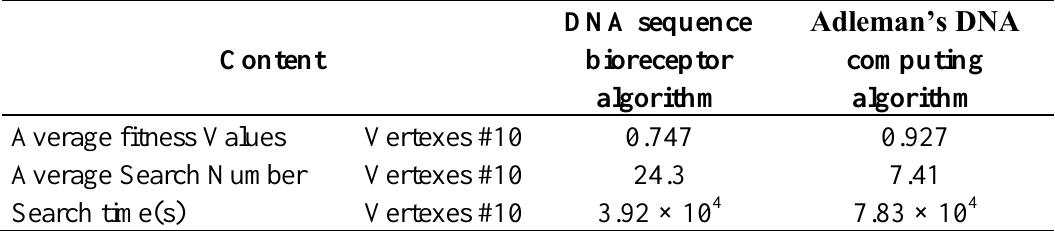
Table 4. Performance of DNA sequence bioreceptor